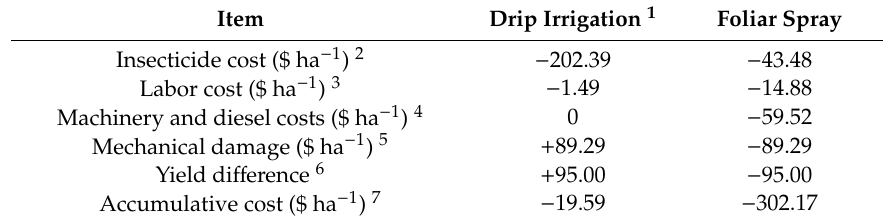
Table 3. Estimated annual costs (in United States dollar ($)) in control of cotton aphid with sulfoxaflor applied via drip irrigation and foliar spray during cotton production in Xinjiang,